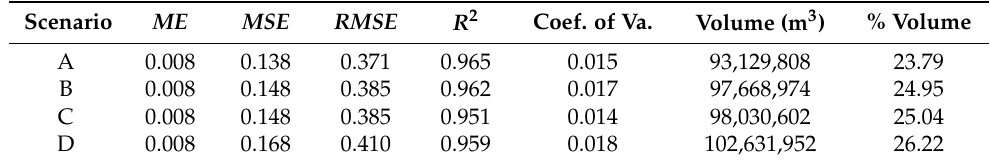
Figure 7. Randomly selected points for cross-validation for the four scenarios considered. In each of the Scenerio A, B, C, and D 400 points were randomly selected for cross-validation. The points in red show the value; the gray line indicates the reference line; while the blue line represents the best fit line. The upper and lower diagonal represents the measured and estimated value respectively. Table 2. Cross-validation results and volume